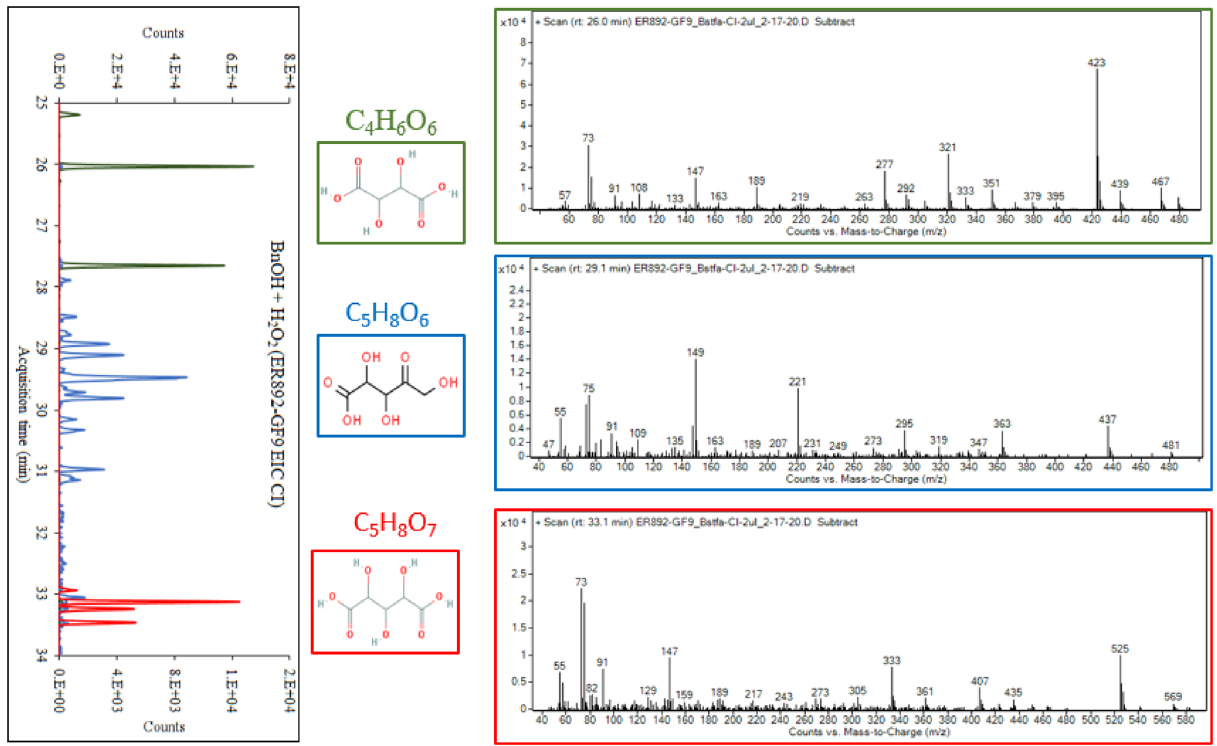
Figure 5. Mass spectra (methane CI) of ester TMS derivatives of meso-tartaric acid (top right), trihydroxy-oxo-pentanoic acid (middle right), and pentaric acid (bottom right), along with the portion of GC-MS extracted ion chromatograms shown in Fig. 6. Chemical formulae and chemical structure associated with each group are given in the middle